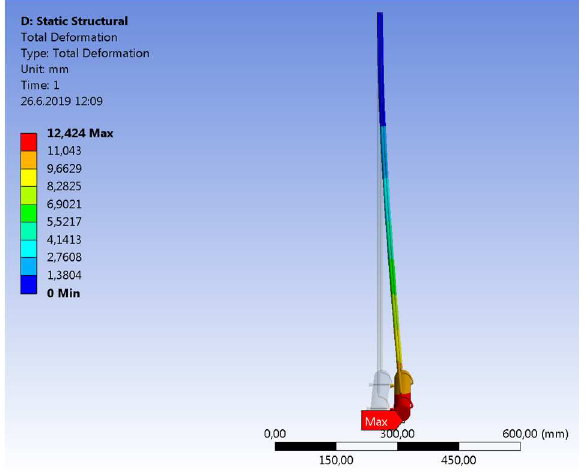
Fig. 6. Computed static deflection by one-way FSI simulation for 60 km/h wind load.